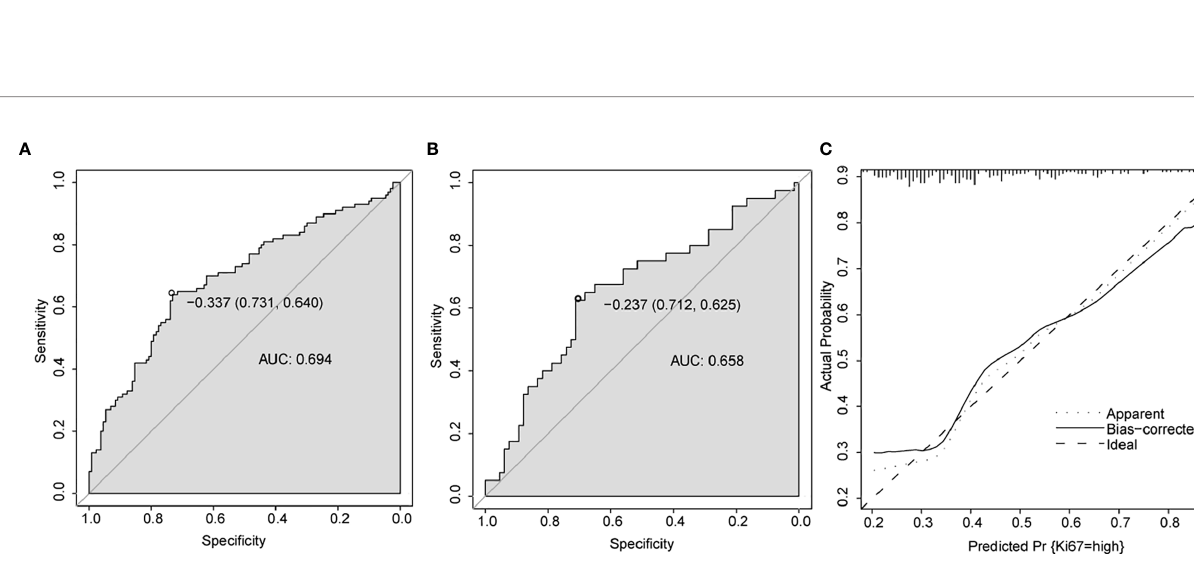
FIGURE 3 | Predictive performance for nomogram. (A, B) ROC analysis of nomogram in training cohort (A) and validation cohort (B) . (C) Calibration plots of the nomogram. AUC, area under the